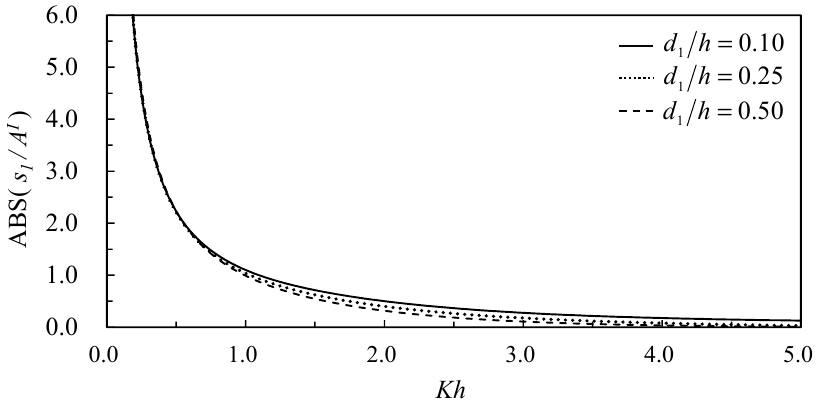
Figure 14. Transmission coefficient versus relative water depth for various submerged depths of the structure ( 𝑑 (cid:2869) / ℎ = 0.10, 0.25, and 0.50 ).